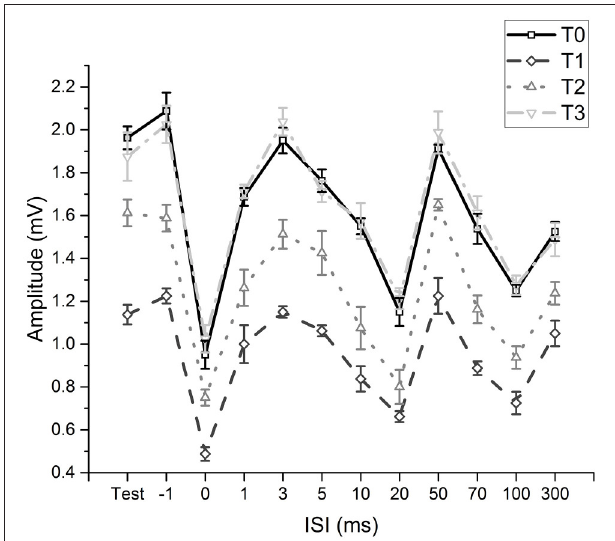
FIGURE 3 | Time-course of effects induced by fMV applied over the FCR muscle. Compared to baseline (T0) fMV decreased unconditioned (test) and conditioned HR amplitude at all ISI tested after 5min (T1) and 30min (T2), while HR amplitude returned to values similar to baseline after 60’ (T3) (all p -values < 0.05). Error bars indicate standard error.